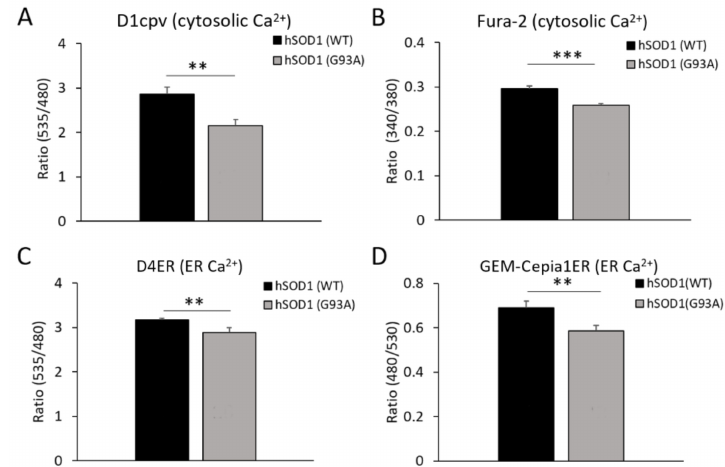
Figure 3. hSOD1(G93A) astrocytes have reduced basal Ca 2 + levels in the cytosol and the ER lumen compared to the healthy counterpart. For measuring the basal [Ca 2 + ] in the cytosol, primary spinal astrocytes were transfected with a plasmidic vector encoding the cameleon genetically-encoded Ca 2 + indicators (GECI) D1cpt ( A ) or loaded with the chemical Ca 2 + indicator Fura-2 ( B ). Both the fluorescence resonance energy transfer (FRET) signal (i.e., the fluorescence ratio between the FRET-acceptor yellow fluorescent protein (YFP) (535 nm) and the FRET-donor CFP (480 nm)) of the cameleon and the fluorescence ratio between the 340 nm and 380 nm excitation wavelengths of Fura-2 underscore significantly reduced cytosolic basal Ca 2 + levels in hSOD1(G93A) astrocytes compared to the hSOD1(WT) counterpart. For measuring the basal [Ca 2 + ] in the ER lumen, astrocytes were transfected with plasmids coding for the ER-targeted GECIs D4ER cameleon ( C ) or GEM-Cepia1ER ( D ). Both the FRET signal (D4ER) and the fluorescence ratio between the 480 nm and 530 nm excitation wavelengths (GEM-Cepia1ER) indicate that the basal ER [Ca 2 + ] is significantly lower in hSOD1(G93A) astrocytes compared to healthy cells. Reported data were collected in at least 12 coverslips from at least 4 di ff erent primary cultures for each experimental condition. ** p < 0.01; *** p < 0.001, unpaired two-tailed Student’s t